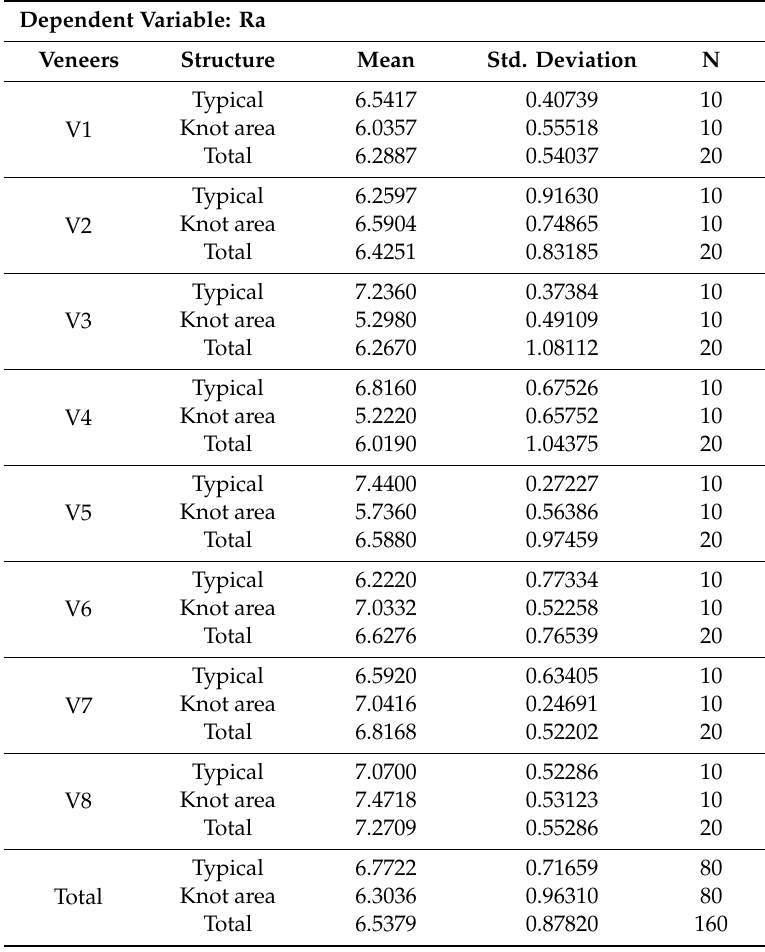
Table 2. Descriptive statistics of dependent variable Ra measured on chestnut veneers of typical and non-typical structure around the